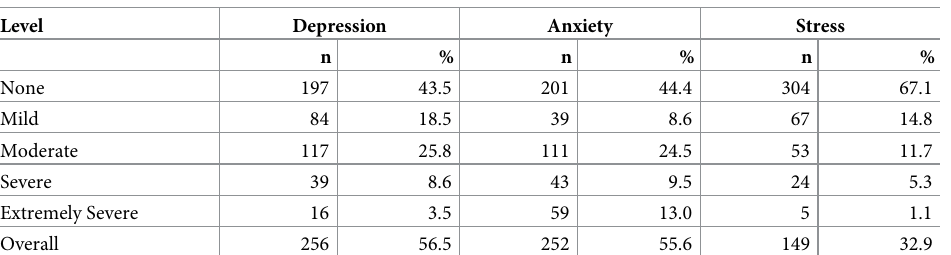
Table 3. Level of symptoms of DAS among the students (n = 453).